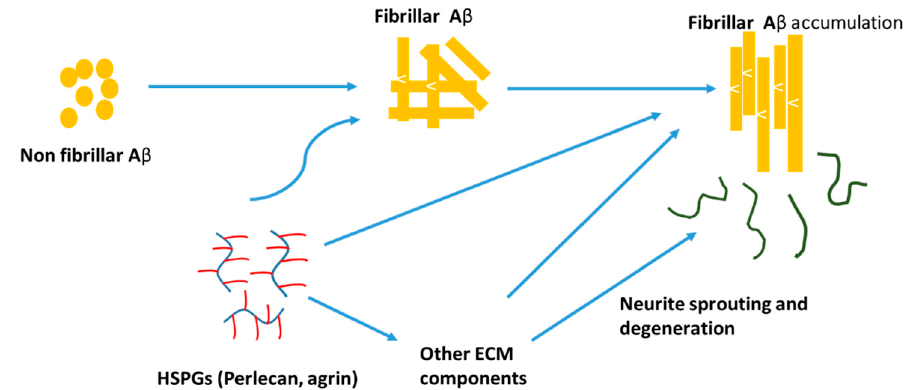
Figure 5. A hypothetical model of heparan sulfate proteoglycan (HSPG) (e.g., agrin/perlecan) involvement in A β pathogenesis. ECM: extracellular matrix.